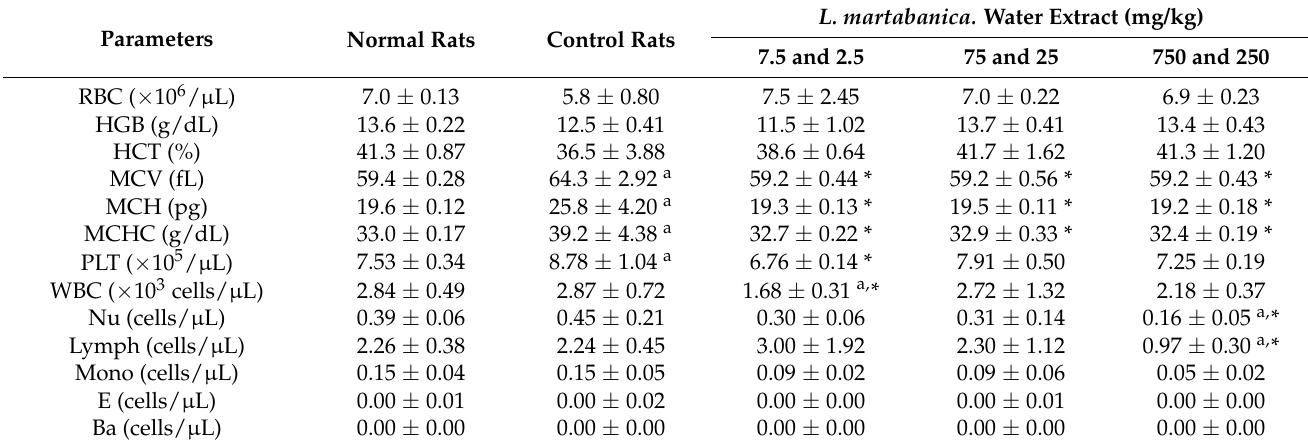
Table 5. Effect of L. martabanica water extract on the hematological values of rats.